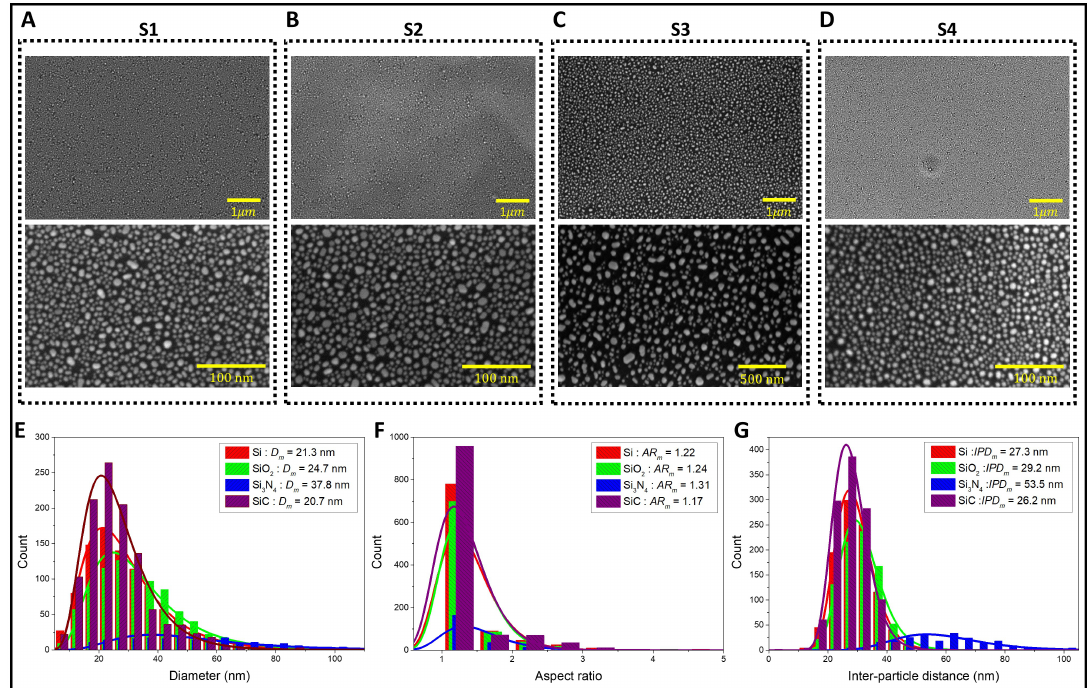
Figure 2. Gold nanostructure deposition on 4 different Si-based ceramic LSPR chips. ( A ) S1 = Si, ( B ) S2 = SiO 2 , ( C ) S3 = Si 3 N 4 and ( D ) S4 = SiC substrates. Histograms and lognormal distribution functions of ( E ) particle diameter ( D ), ( F ) aspect ratio ( AR ) and ( G ) inter-particle distance ( IPD ) on 4 different supporting substrates. D represents the mode values of negatively skewed